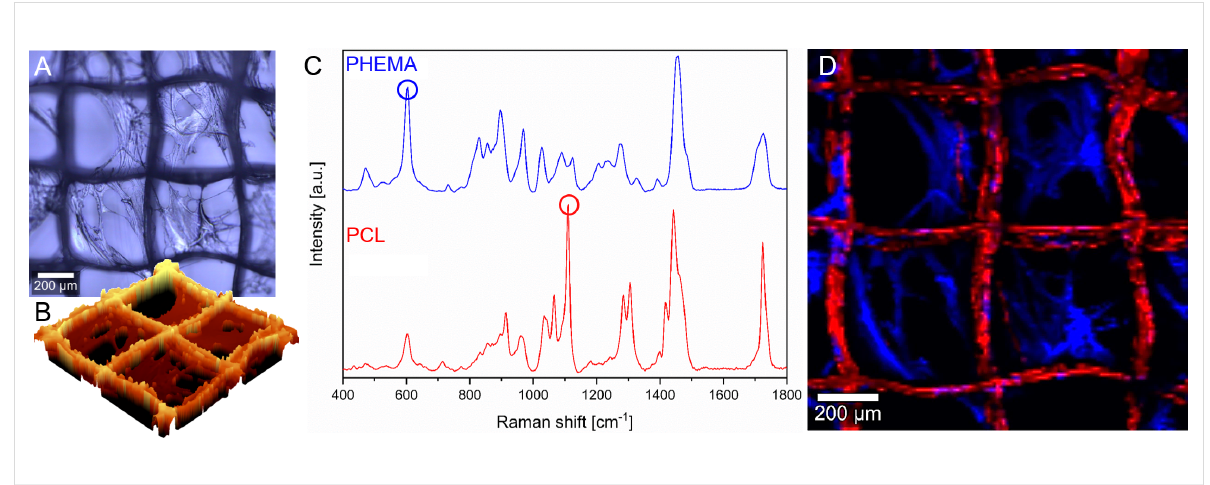
Figure 2: A) Optical photograph of an SIPGP-coated sample. B) 3D topography reconstruction of the SIPGP-coated scaffold. C) Raman spectra depicting the fingerprint region of PHEMA and PCL with the two significant peaks of PHEMA (829 cm − 1 ) and PCL (1111 cm − 1 ) marked with